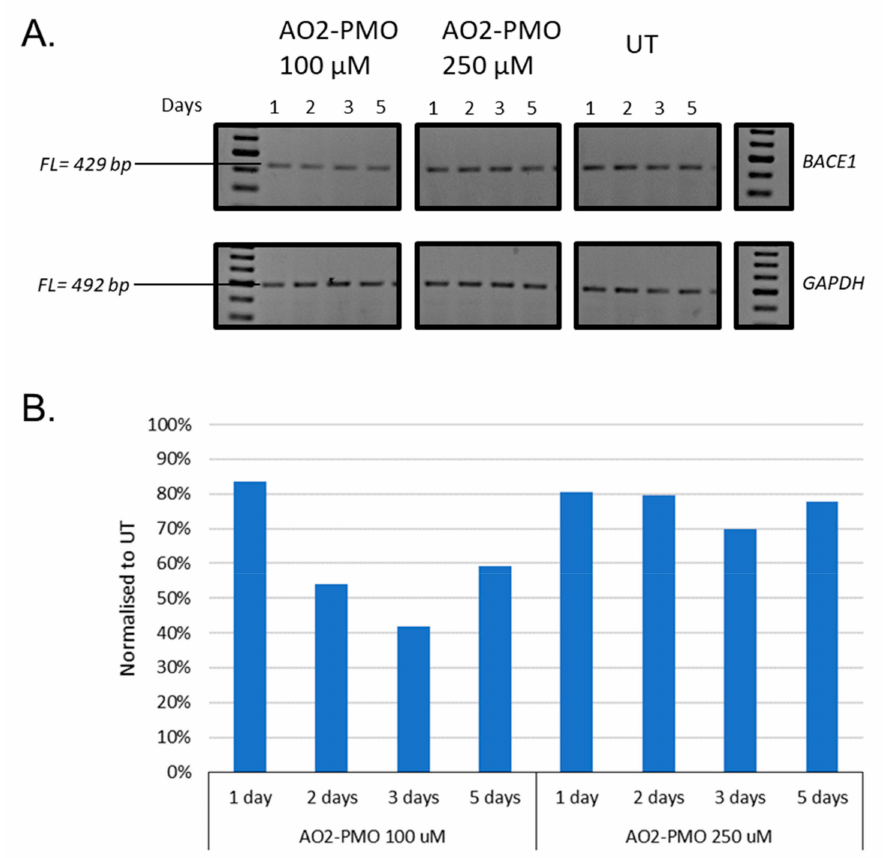
Figure 5. ( A ) Representative RT-PCR analysis of the BACE1 and GAPDH transcripts after treatment with AO2-PMO targeting exon 2 for 1, 2, 3, and 5 days at 100 µ M and 250 µ M inHEK293 cells. FL, full-length; UT, untreated; SCR, scrambled sequence; GAPDH was used as a loading control. The gel images were cropped to highlight the BACE1 specific products and the corresponding house-keeping gene control GAPDH . The original images are shown in Figure S5 (Supplementary Information). ( B ) Densitometry analysis of BACE1 transcript downregulation in HEK293 cells in